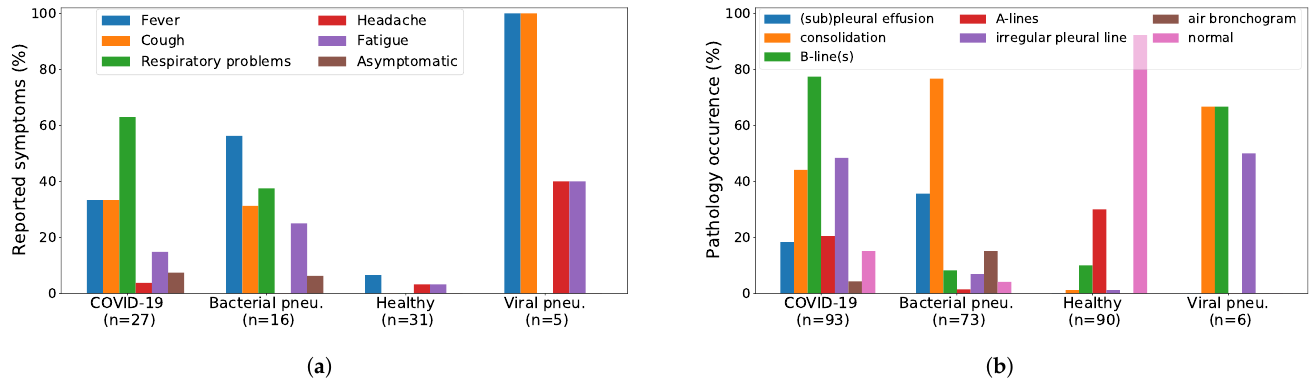
Figure 2. Symptoms and pathological patterns are grouped by patient condition. ( a ) In the 30% of our dataset where symptoms were available fever, cough, and respiratory problems were reported most often for patients with bacterial or viral pneumonia. ( b ) Bacterial pneumonia is typically characterized by consolidated areas, while B-lines and pleural irregularities are usually indicative for viral infection. ( a ) Reported symptoms, ( b ) Pathological